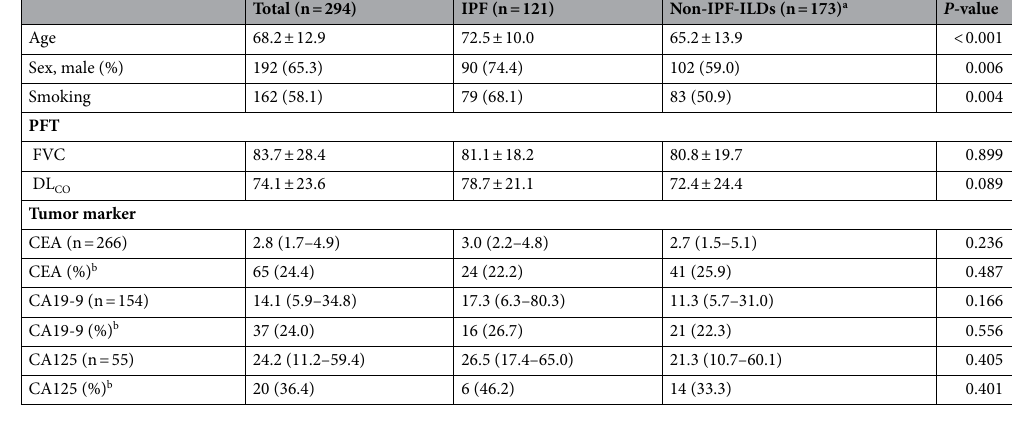
Table 2. Baseline characteristics of 294 patients according to the diagnosis. Data are expressed as mean ± SD, median (interquartile range), or frequency (%). IPF idiopathic pulmonary fibrosis, ILD interstitial lung disease, PFT pulmonary function test, FVC forced vital capacity, DL CO diffusing capacity of the lung for carbon monoxide, ILD interstitial lung disease, CEA carcinoembryonic antigen, CA carbohydrate antigen. a Non- IPF-ILDs: idiopathic nonspecific interstitial pneumonia (n = 16), cryptogenic organizing pneumonia (n = 11), connective tissue disease associated ILDs (n = 51), hypersensitivity pneumonitis (n = 1), unclassifiable ILD (n = 70), others (n = 24). b Proportion of abnormal tumor marker values (normal range: CA 19-9, 0–37 U/mL; CA 125, 0–35 U/mL; CEA, 0–5 ng/mL).